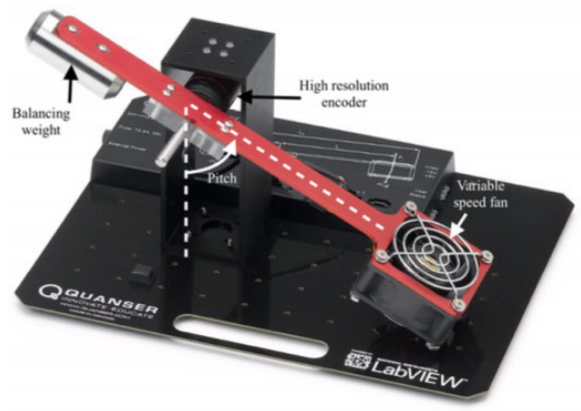
( c ) Figure 4. ( a ) Identification Section, ( b ) FOPI controller design Section, ( c ) Discrete-time FOPI con- troller Section. 5. Results and Discussion The proposed method and the designed toolbox are validated using an experimental Vertical Take-Off and Landing (VTOL) unit [43], as indicated in Figure 5. The major com- ponent of the VTOL platform is the cantilever beam. This is connected to the base platform through a spinning rod. A variable speed fan is mounted on the right end of the cantilever beam, and a counterweight on its left. At one-third of the whole length of the beam, the anchoring point is located, near the counterweight. The input to the system is the voltage applied to the variable speed fan, which can take values between 0 V and 10 V. This allows the fan to spin and produce thrust, causing the beam to rise.